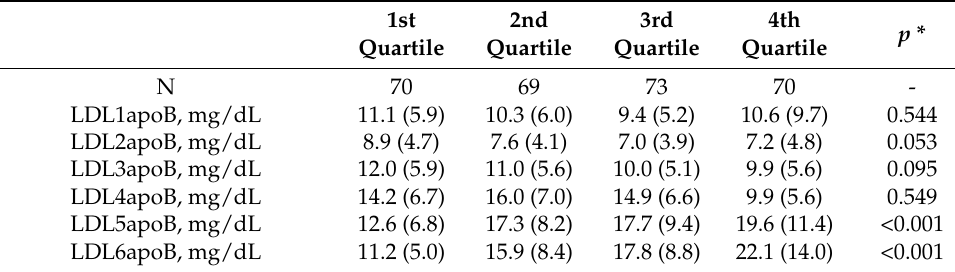
Table 4. LDLapoB in LDL subclasses according to LDLapoB/LDLC meas quartiles.